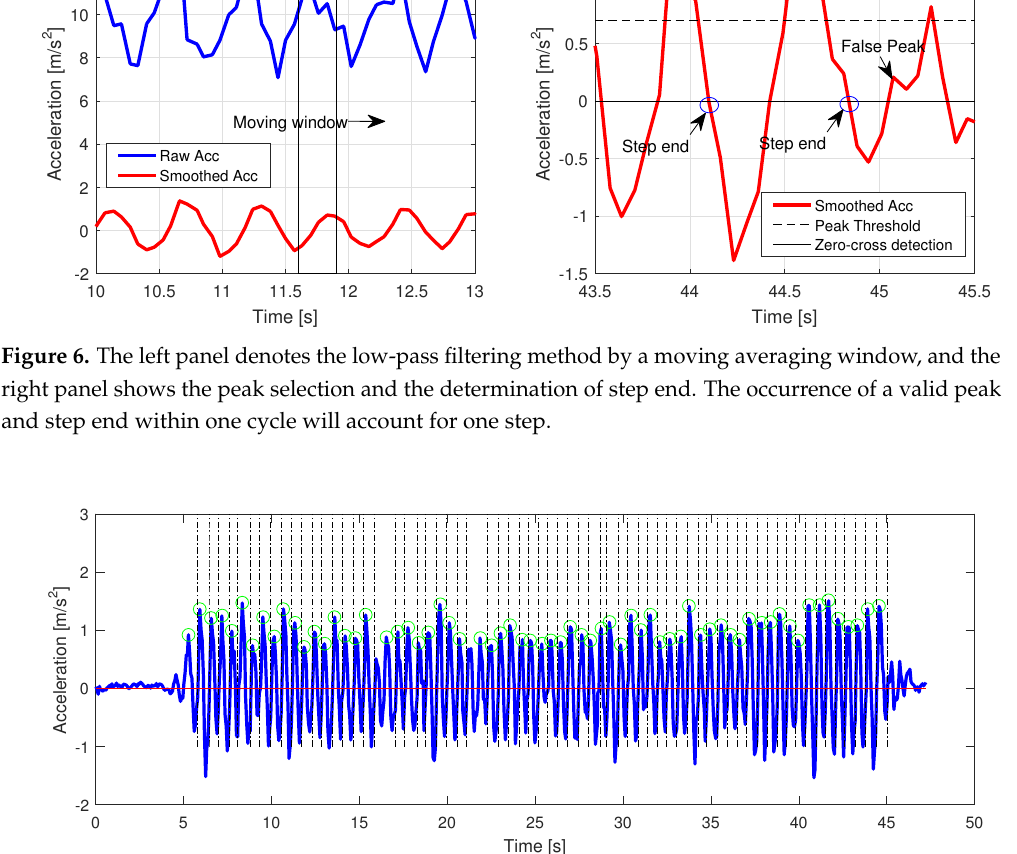
Figure 7. An experiment of a pedestrian walking at the normal status (ground truth is 67, and the detected step count is also 67). The green circle represents the detected steps, and the subsequent black dashed line denotes the finish time of this